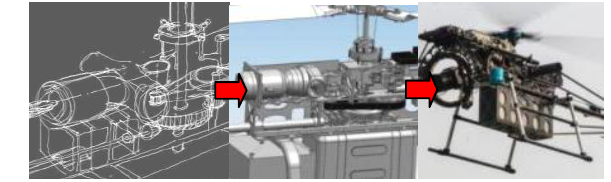
Figure 4 R&D of a turbine-shaft UAV